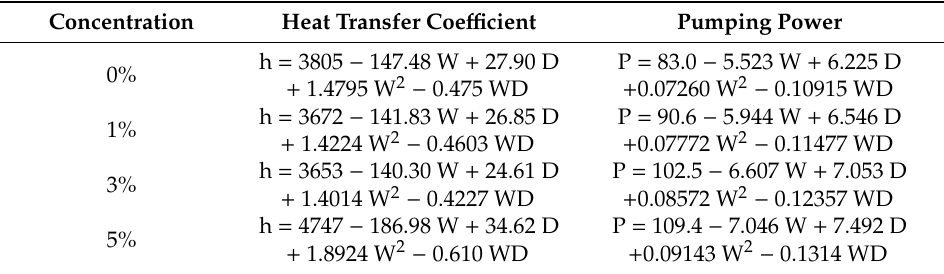
Table 9. Correlations of the heat transfer coefficient and pumping power.